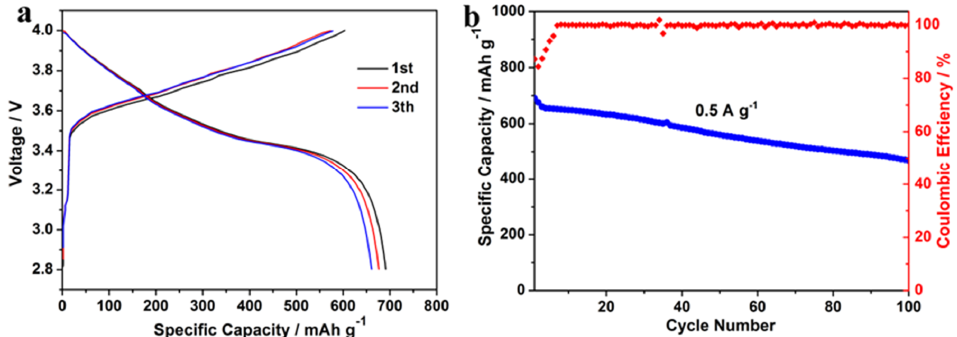
Figure 5. Electrochemical performance of SiNPs@CFs/LCO full cells in the potential range 2.8–4.0 V: ( a ) Full battery charge/discharge profiles at 0.5 A·g −1 ; ( b ) anode capacity of the full battery for 100 cycles at 0.5 A·g −1 . The capacity is based on the mass of the SiNPs@CFs sample.